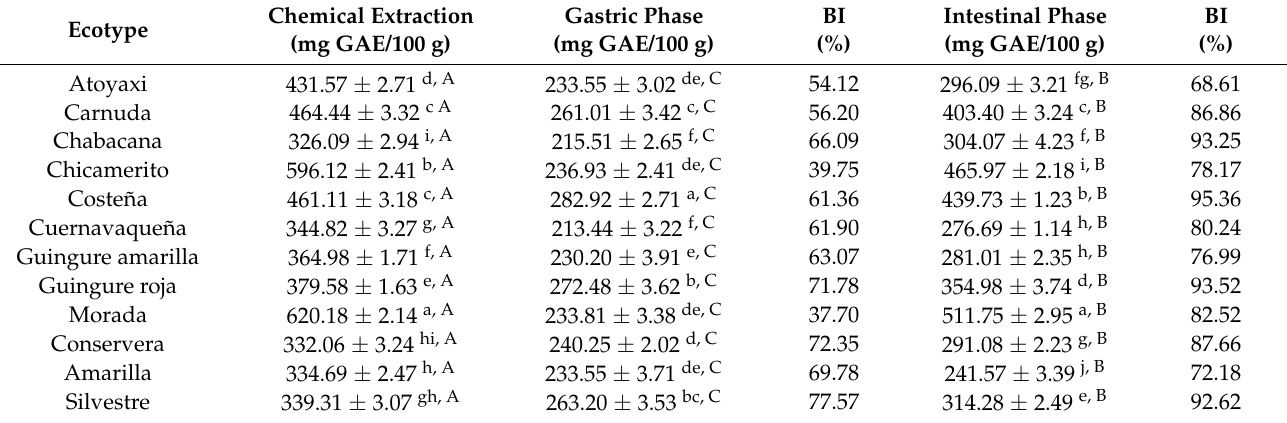
Table 4. Total phenolic content and bioaccessibility index of 12 ecotypes of S. purpurea L. before and after in vitro digestion.